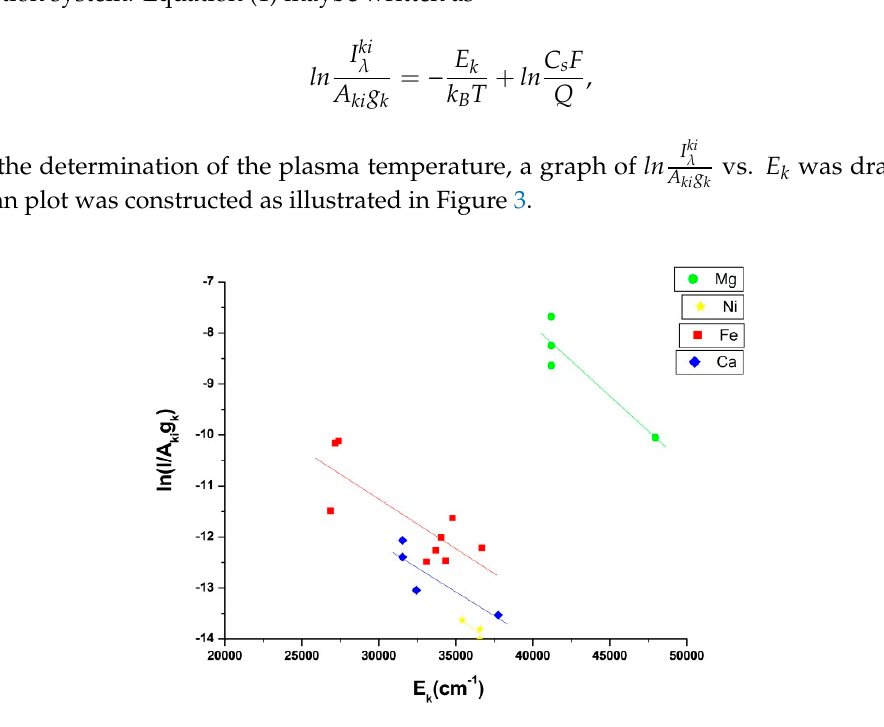
Figure 3 . Boltzmann plot for different emission lines of elements for the Dergaon meteorite. Figure 3. Boltzmann plot for di ff erent emission lines of elements for the Dergaon